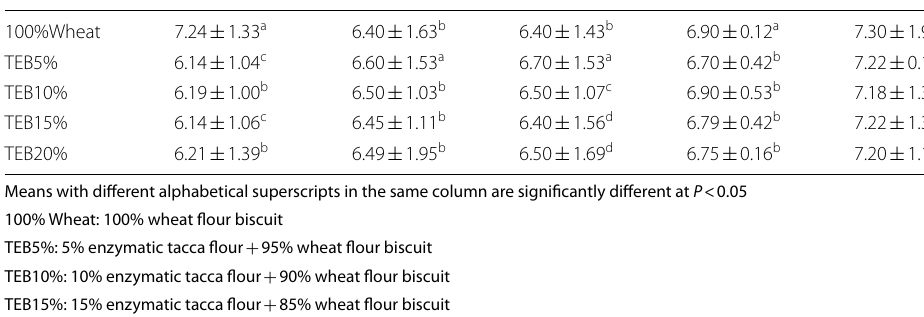
Table 3 Sensory attributes of tacca–wheat biscuit